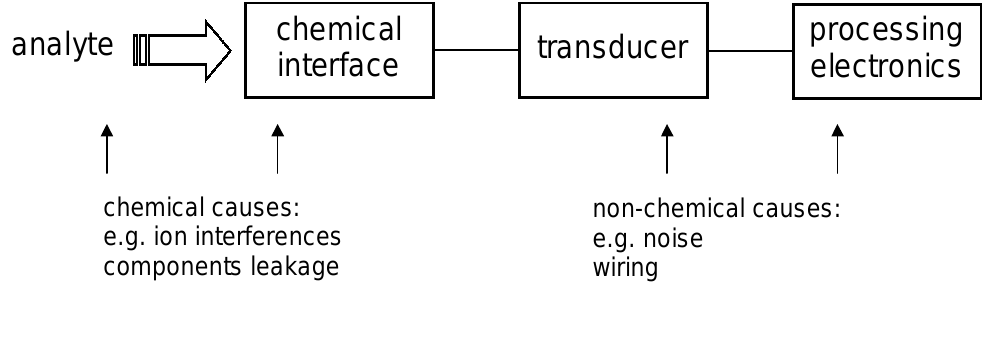
Figure 1. Chemical sensor construction and possible sources of